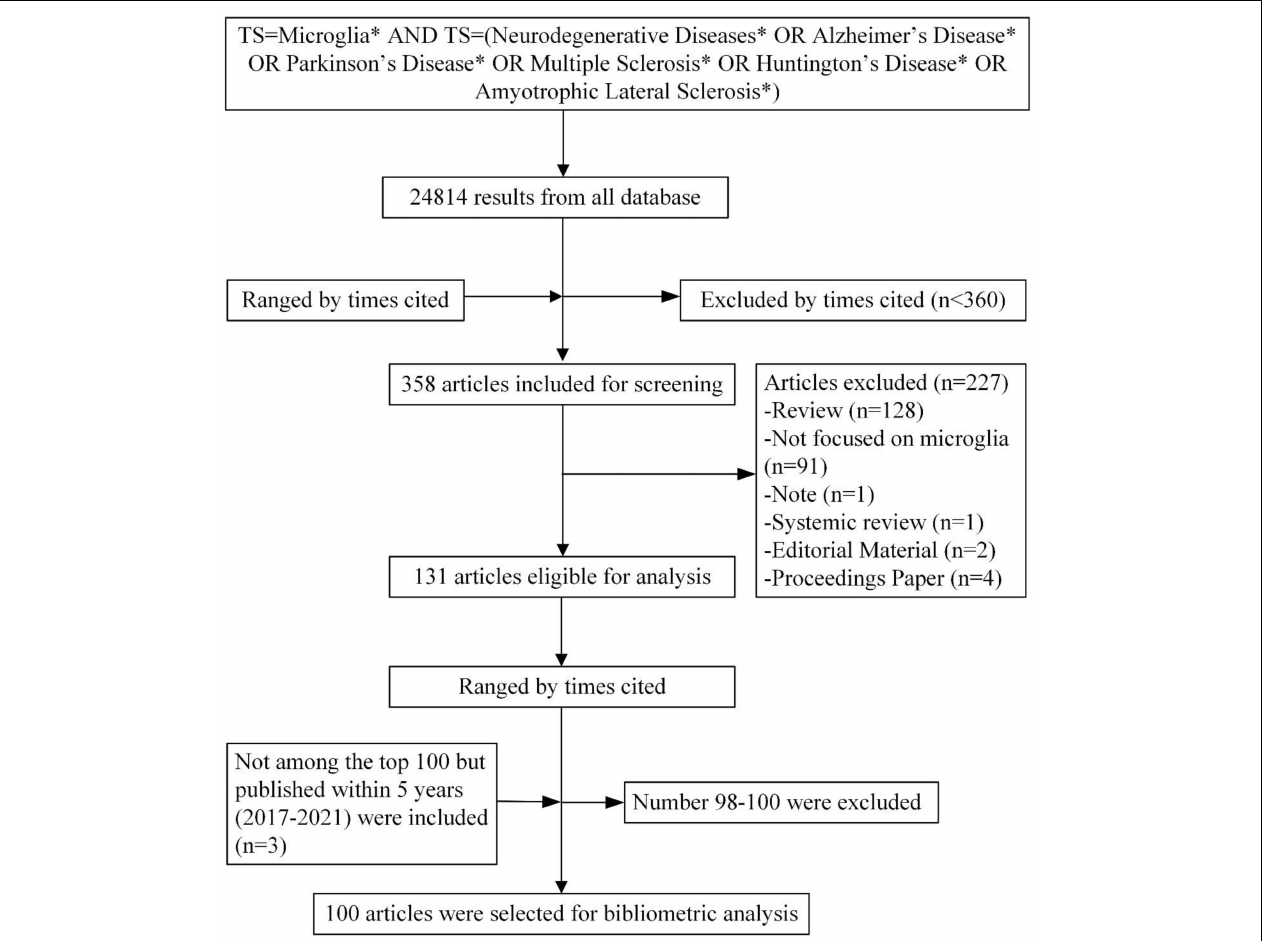
FIGURE 1 | Flowchart of the literature search and article screening. (* is a wildcard character).